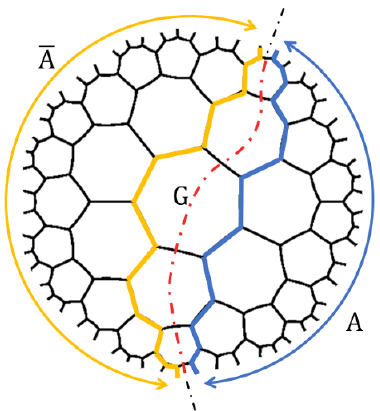
Figure 30 . The blue (orange) line is interval A ( (cid:22) A ). The red dashed line is line G with minimal cuttings. The blue (orange) polyline corresponds to tensor chain M A ( M (cid:22)